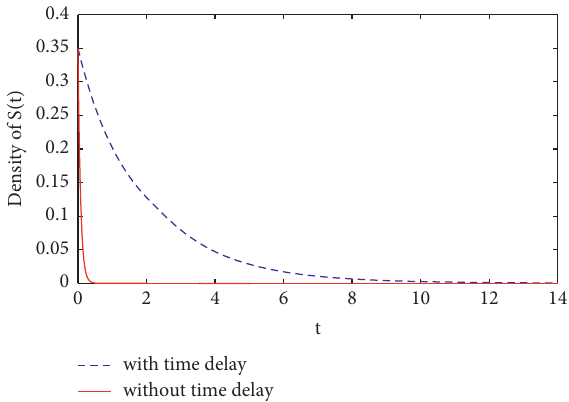
Figure 8: The impact of time delay with optimal